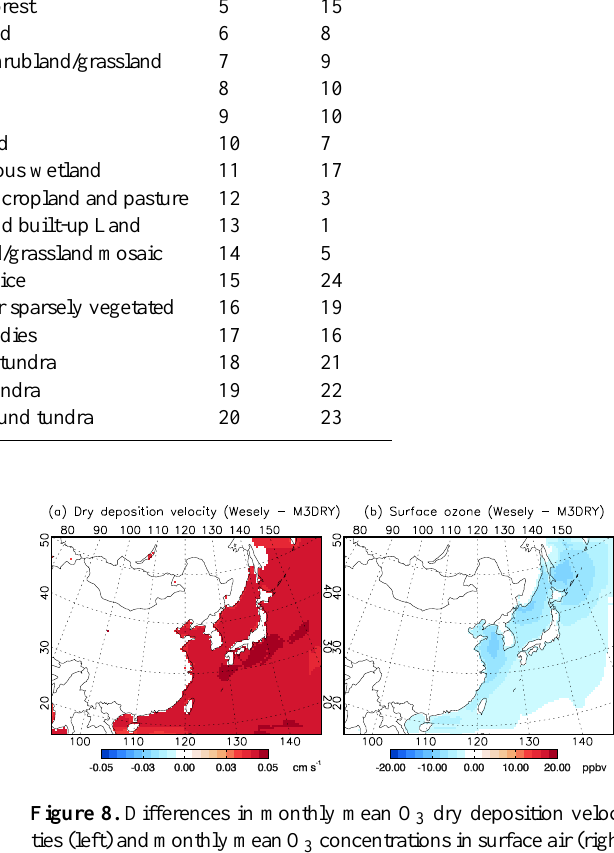
finer spatial resolution, the nested model yields lower